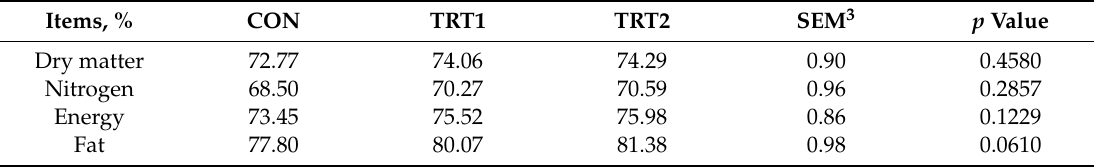
Table 4. The e ff ect of dietary DOL supplementation on apparent total tract digestibility in broilers † , ‡ .